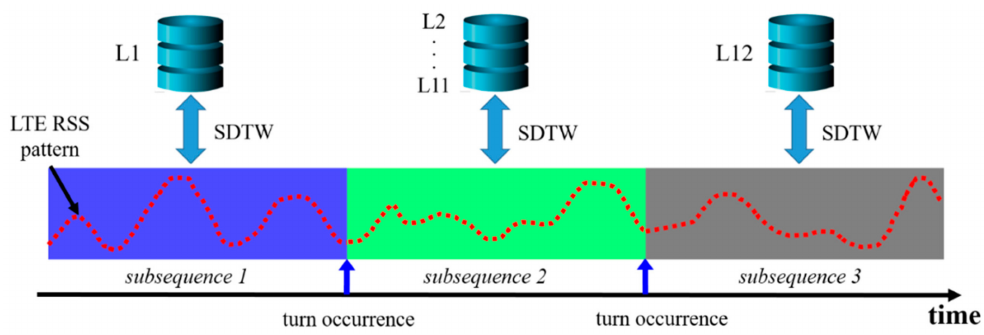
Figure 12. ESDTW is executed using the user buffer and candidate DB. The user buffer is divided into subsequences based on the vehicle’s turn motion. Each SDTW is performed using the subsequence and selected